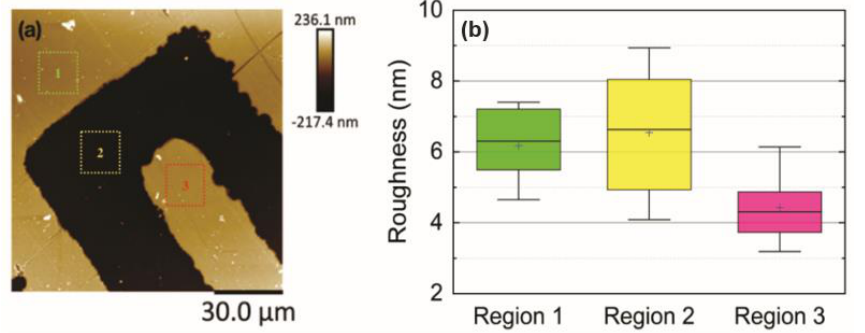
Figure 7. Roughness analysis obtained by Atomic Force Microscopy. ( a ) AFM topographic image indicating regions in which roughness analysis was performed. Each measure square has 10 µm 2 , and 12 measurements were acquired for each region. Region 1 (green square) corresponds to the sensor surface between the digits, Region 2 (yellow square) corresponds to the quartz substrate on which the gold layer was deposited, and Region 3 (red square) corresponds to the surface of the digit. ( b ) Boxplot graphs comparing the roughness values and average for each region. The mean values of quadratic roughness for each region were 6.17 ± 1.3 nm, 6.54 ± 1.9 nm, and 4.42 ± 1.0 nm for Region 1, Region 2 and Region 3, respectively.